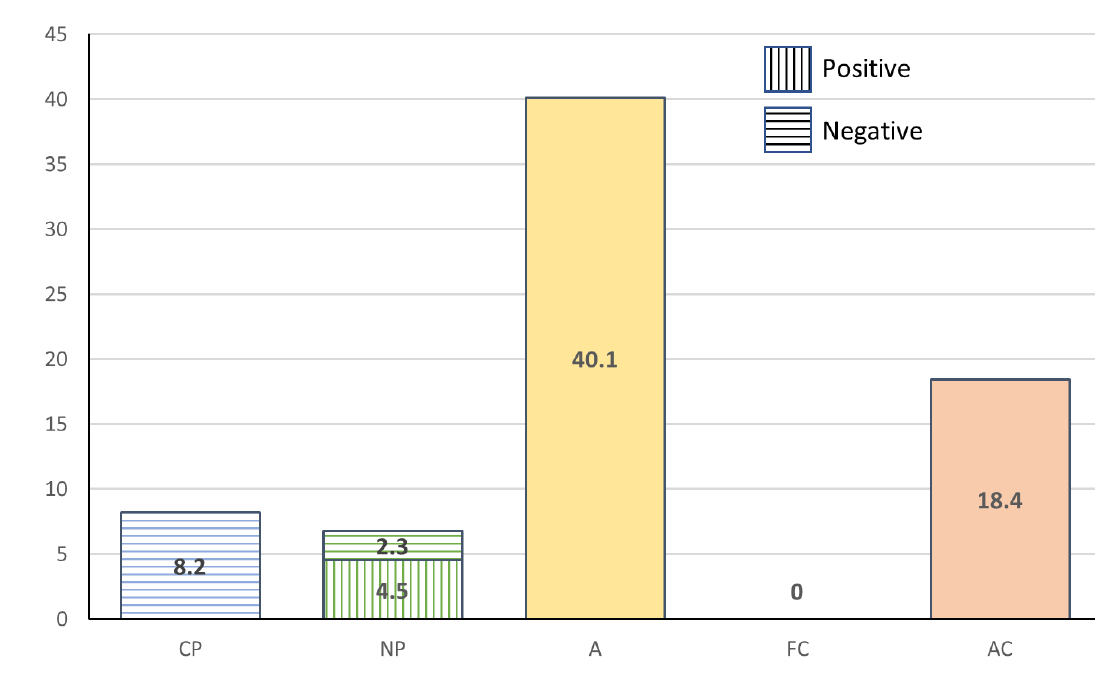
Figure 3: Alcoholic Suicide Egogram